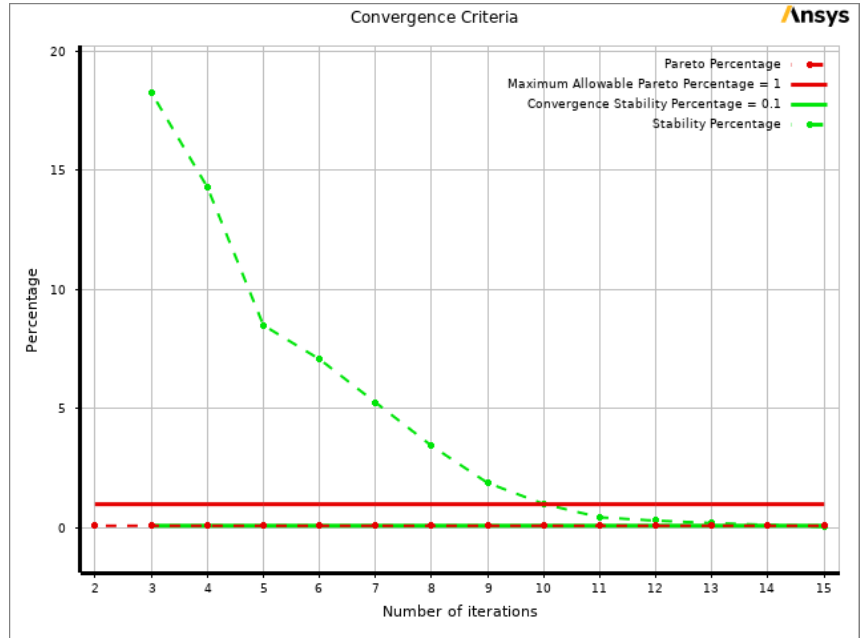
Figure 19. Convergence criteria.